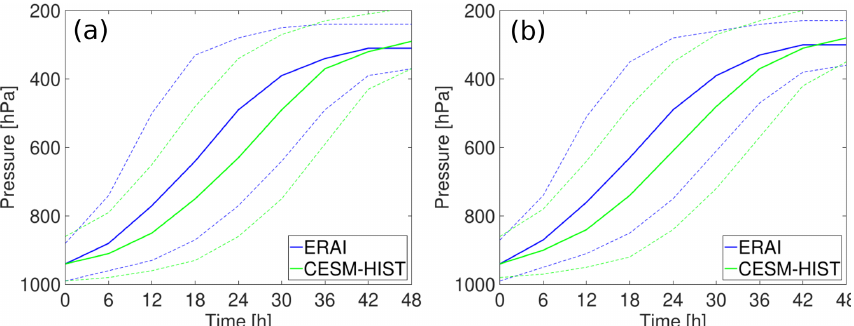
Figure 3. Mean time evolution of pressure (in hPa) along all WCB trajectories in (a) boreal winter and (b) boreal summer. Solid lines denote the mean over all trajectories and dashed lines the 10th and 90th percentiles for ERA-Interim (blue) and HIST (green).